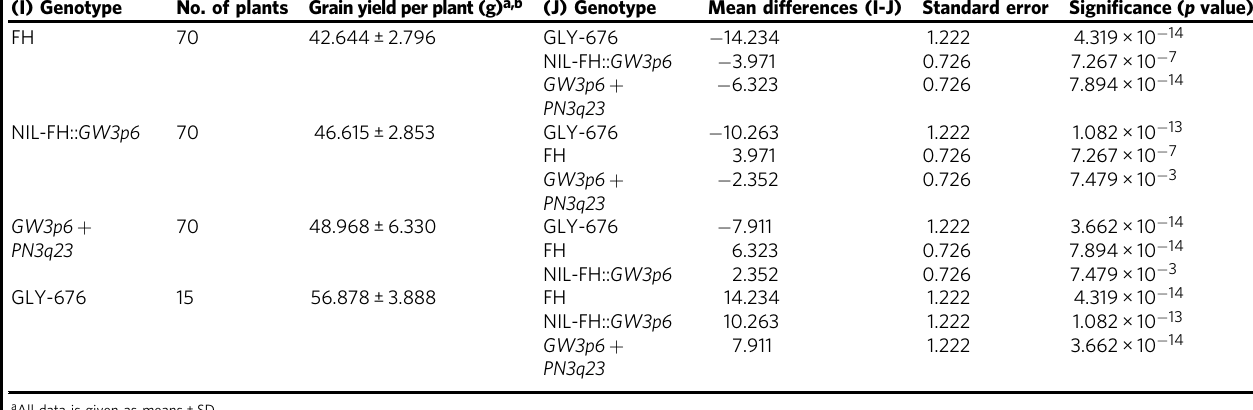
Table 2 Grain yield per plant of different plants harboring heterosis genes (I)